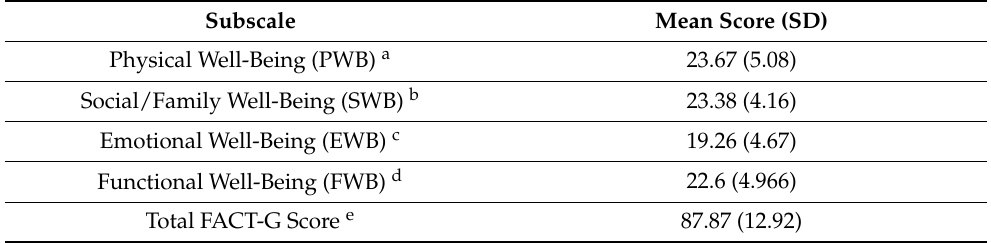
Table 2. Results from FACT-G survey among a sample of firefighter cancer survivors ( n = 27).